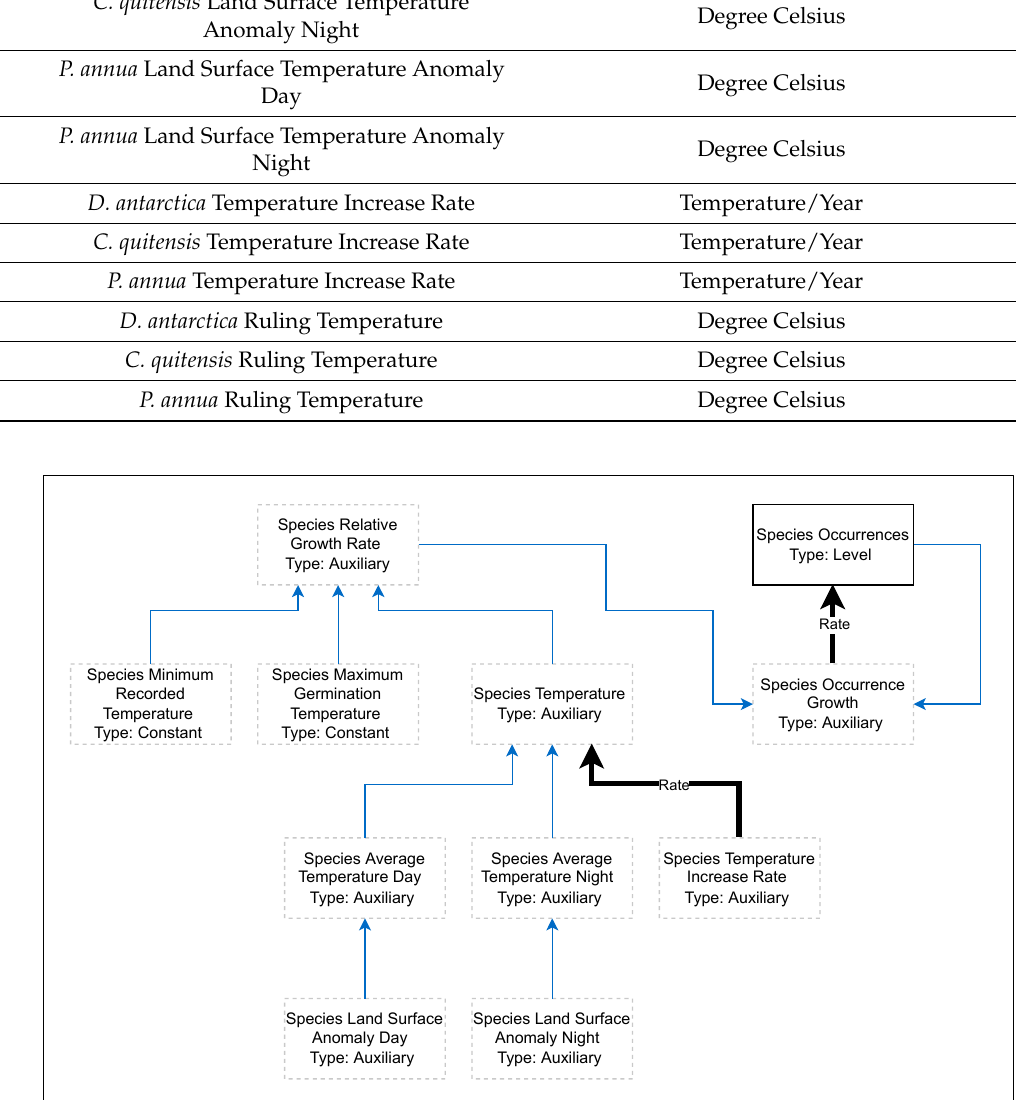
Figure 3. Model Diagram.